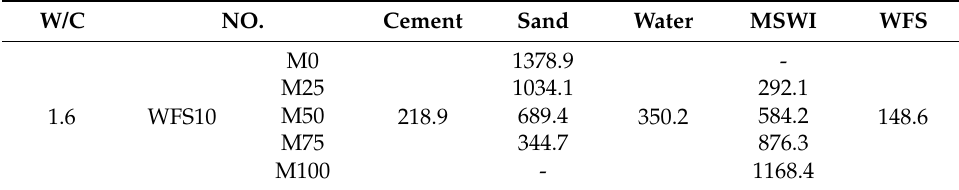
Table 3. Mixture proportions of controlled low-strength material (CLSM) (unit: kg/m 3